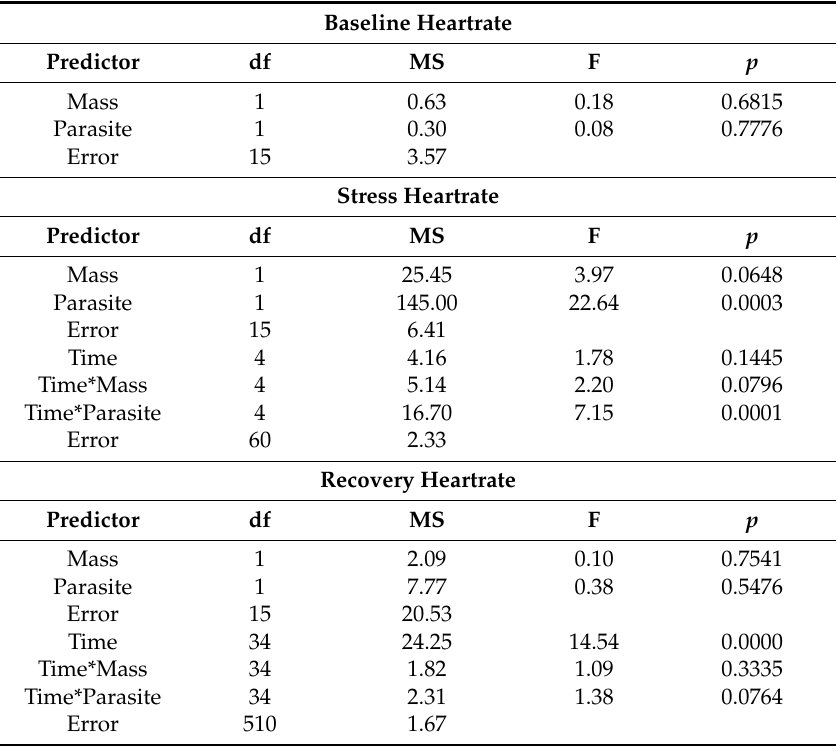
Table 2. Summary of models that examined effects of nematode parasite infection on beetle heartrate before, during, and following stress application in the first experiment ( n = 19